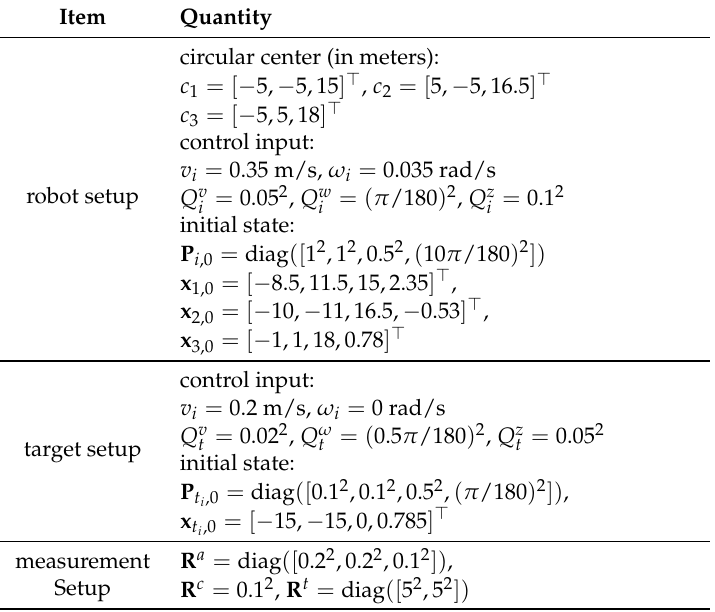
Table 2. Experiment